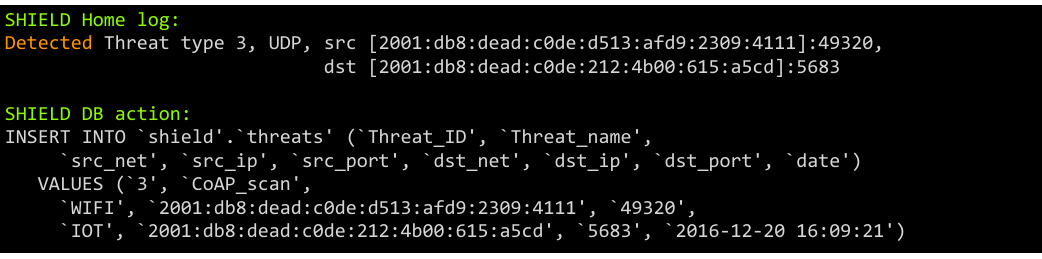
Figure 8. Detection for IoT